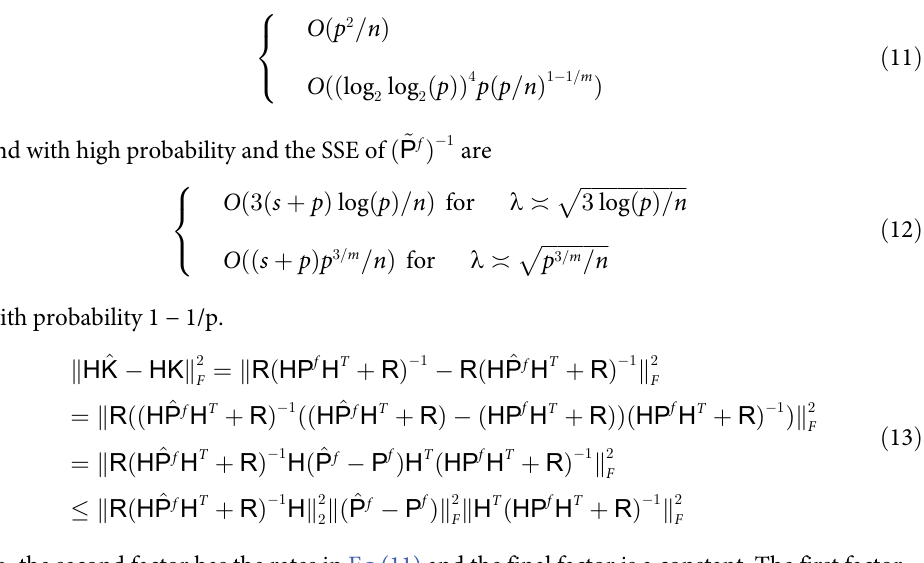
ffiffiffiffiffiffiffiffiffiffiffiffiffi p Þ for state vectors with bounded 4 m th moments and O ð p 3 = m = n